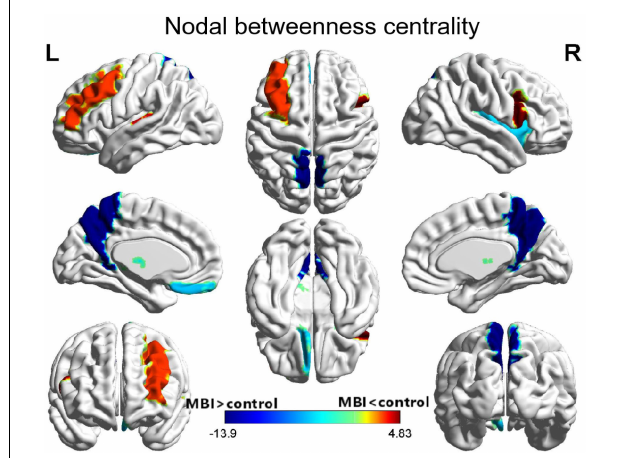
FIGURE 3 | Differences between MBI group and normal control group in nodal betweenness centrality. Regions that showed significant differences between both groups in regional network topology were presented by the AUC of full connectivity mapped on ICBM152 surface template. The color bar represents log(1/ p -value). The hot colors in the color bar represent regions that have significantly higher nodal betweenness centrality in the normal controls than in the MBI group, while cold color indicates regions with significantly higher nodal betweenness in the MBI group than in the normal controls. L, left; R,